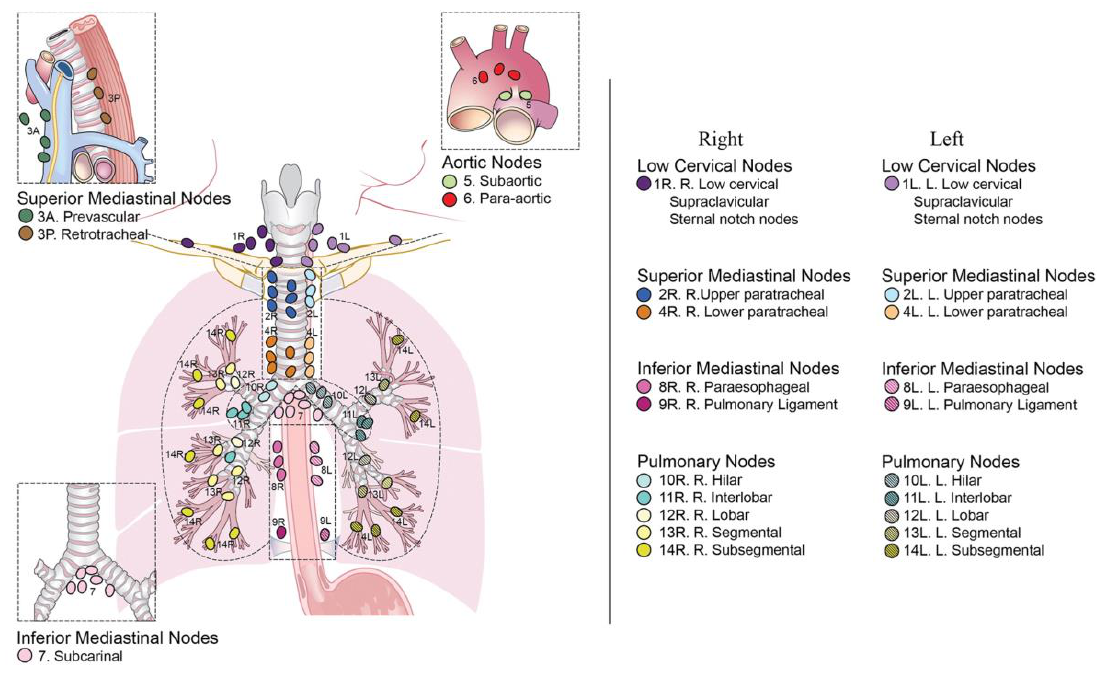
Figure 1. IASLC mediastinal lymph node map, courtesy of El-Sherief et al.